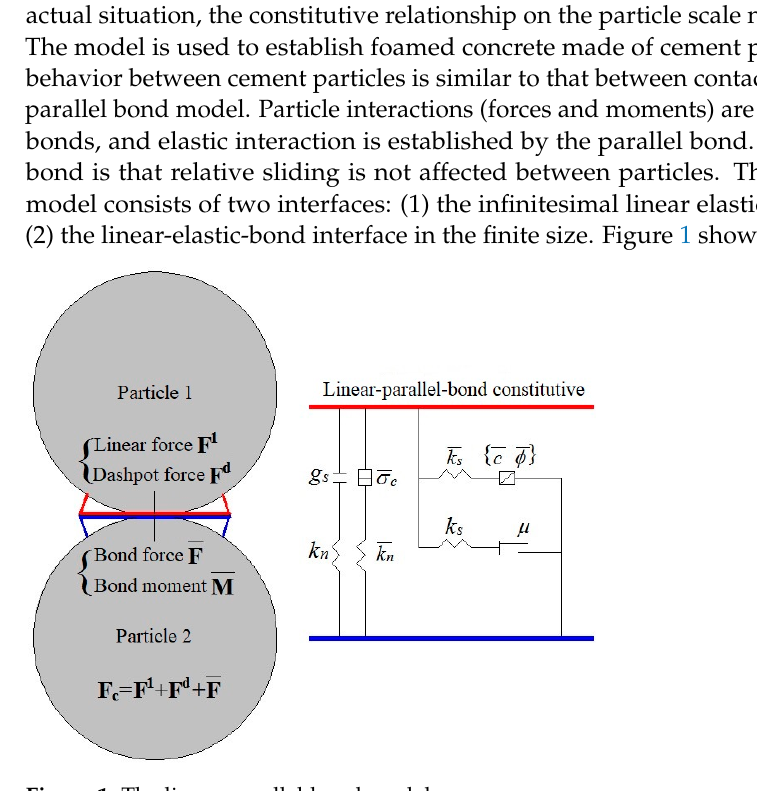
Figure 1. The linear-parallel-bond model. The surface gap ( L s ) between a pair of particles is defined as the difference between the contact gap ( L c ) and the reference gap ( L r ), as shown in Figure 2. The contact is activated ( L s ≤ 0), while the force-displacement law will not be considered for the inactive